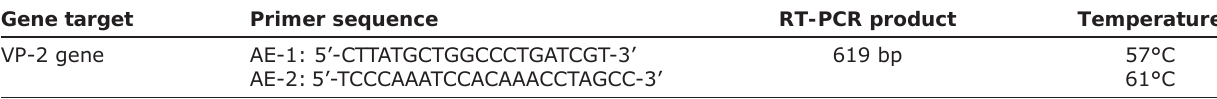
Table-2: Primer used for amplification of VP-2 gene of AEV [20]. Gene